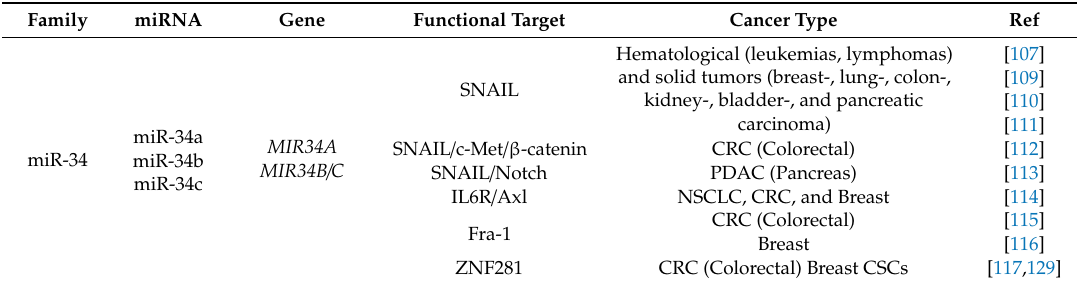
Table 2. Representative EMT and metastasis-suppressor noncoding genes (miRNAs) silenced by DNA